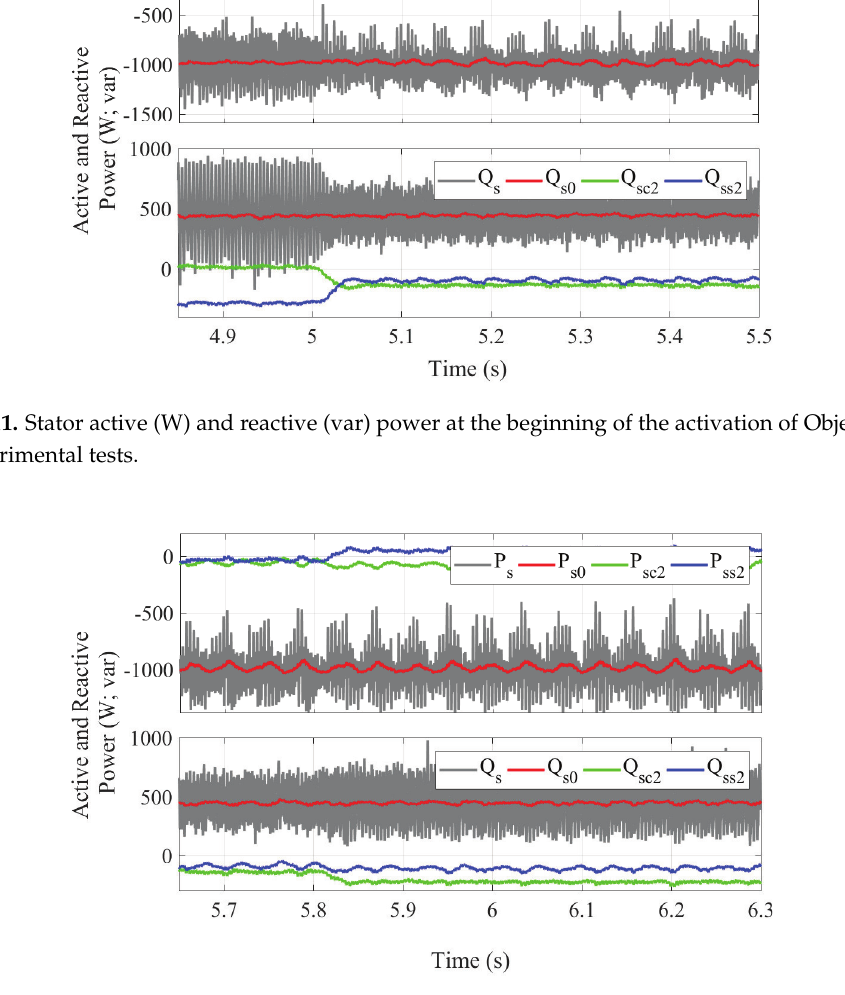
Figure 12. Stator active (W) and reactive (var) power at the beginning of the activation of Objective III for experimental